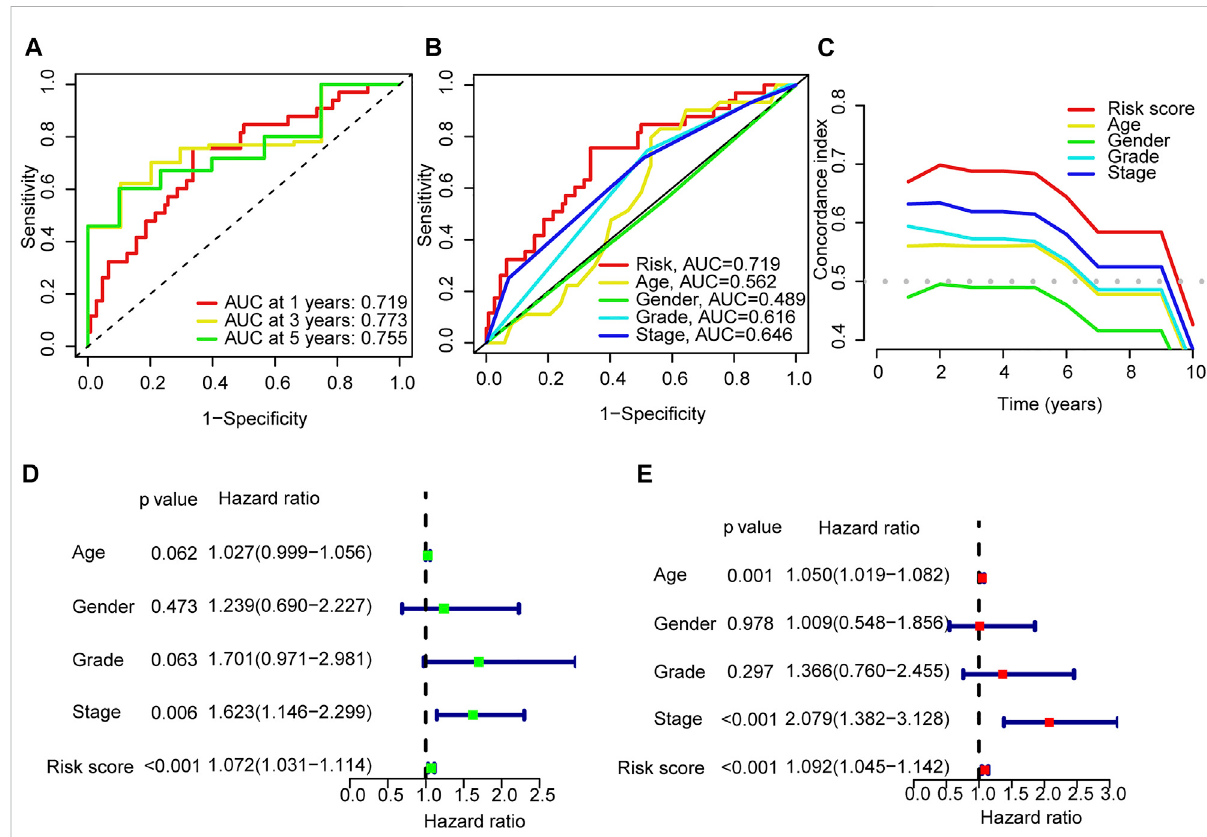
FIGURE 4 Validation of the model. (A) Time-dependent ROC curve analyses for survival of all patients based on the risk score model. (B) Comparision of the ROC curves of risk score, patient age, patient gender, tumor grade and tumor stage. (C) The C-index curves of risk score, patient age, patient gender, tumor grade and tumor stage. (D,E) Uni-Cox and multi-Cox analyses of overall survival for risk score, patient age, patient gender, tumor grade and tumor